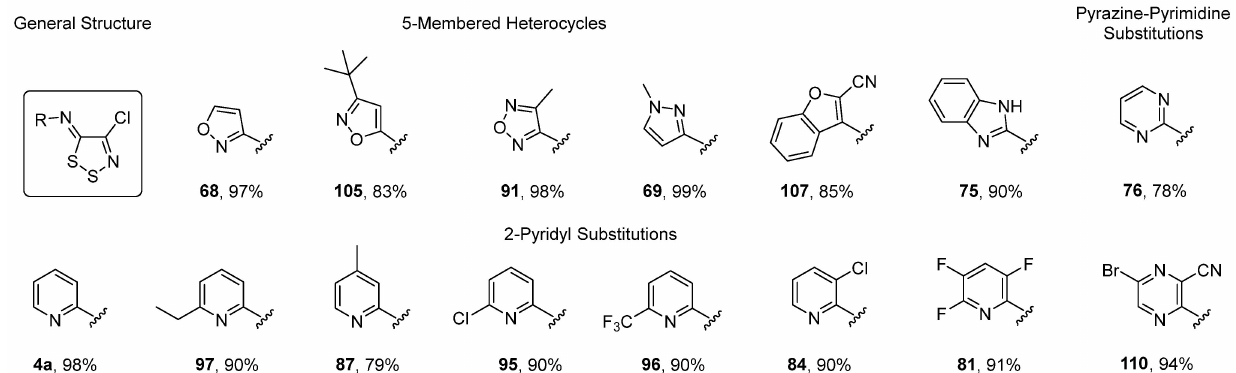
Figure 16. Botyrtis (beans) preventive ≥ 70% efficacy at concentration of 500 ppm.